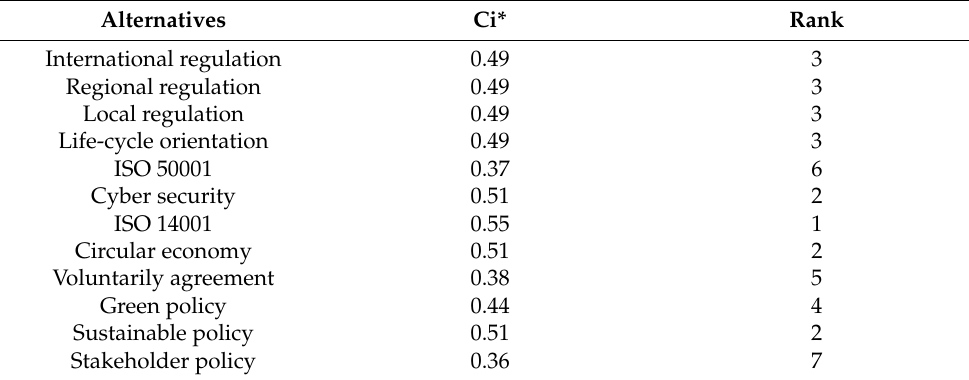
Table 7. Ranking of alternatives in policy and regulation